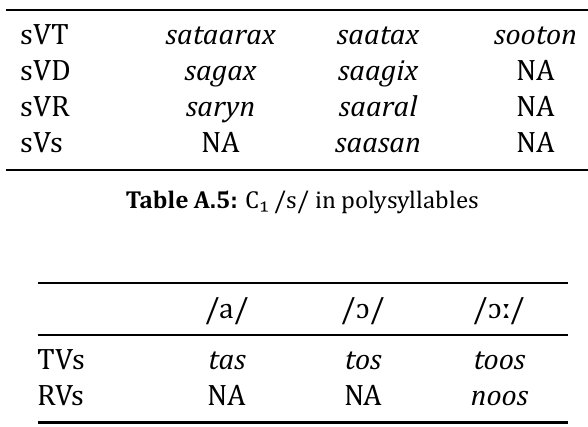
Table A.6: C₂ /s/ in monosyllables